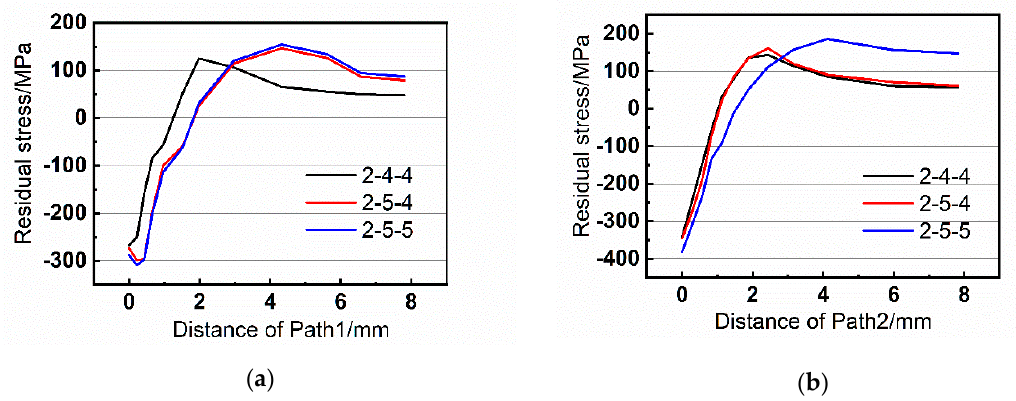
Figure 13. Residual stress of the paths with strap thickness of 2 mm. ( a ) Path1 and ( b ) Path2.